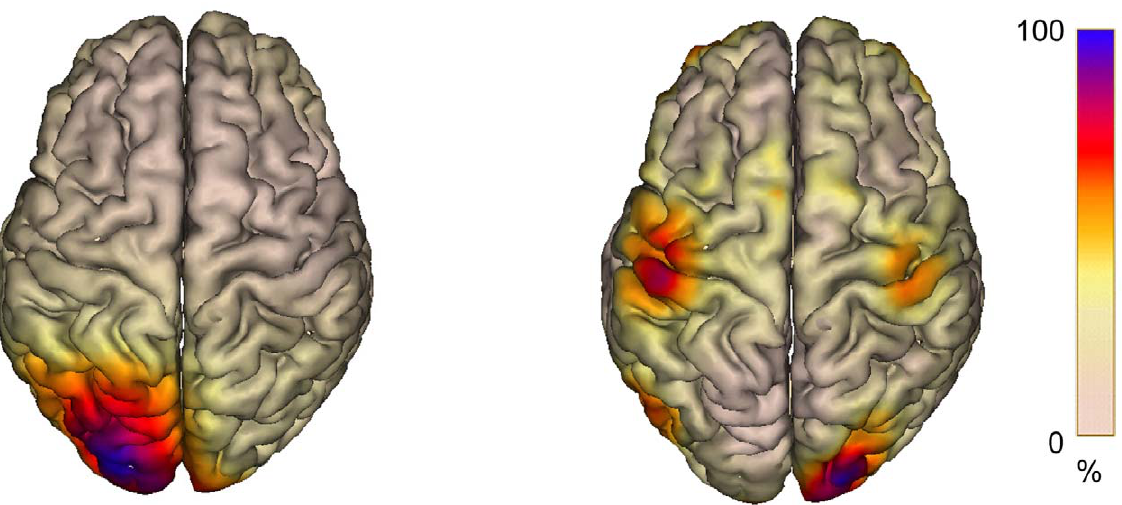
Figure 3. Localization of the Effects in Alpha and Mu Power. The alpha and mu effects (pause – observation) were calculated using minimum- norm analysis in BESA 5.1.6. (Brain Electrical Source Analysis, MEGIS Software, Germany). The minimal norm was computed with spatiotemporal weighting according to [49] fitted to an individual Talairach transformed brain surface. Effects are scaled with respect to the maximum difference between pause and observation intervals (100%, in blue). The left sources represent the alpha power, reflecting the difference between pause and observation intervals in the detection task, and the right sources represent the mu power, reflecting the difference between pause and observation in the imitation task.